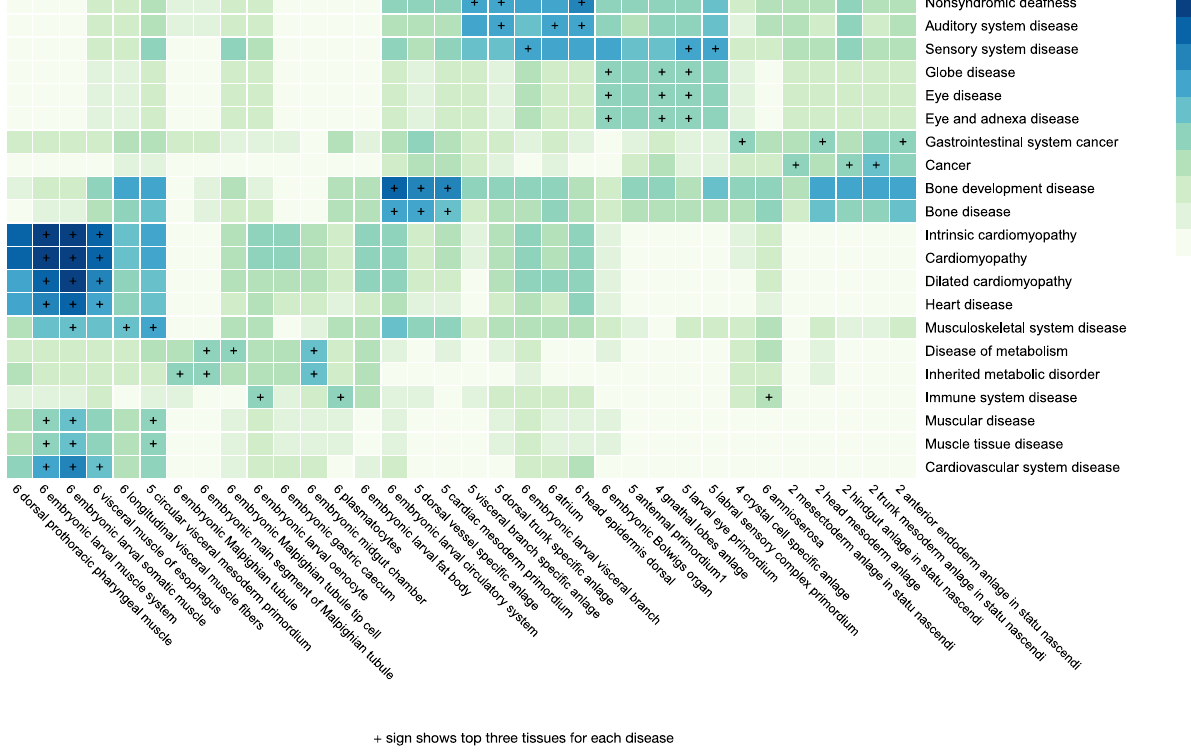
Fig 5. Prioritization of fly developmental tissues and stages for modeling human disease. Heatmap showing false discovery rate (-log10 FDR) for enrichment of human OMIM disease gene functional orthologs in each tissue-stage combination, based on FIND predictions (p-value is computed based on PAGE). The number before tissue names indicate stages (1: stage 1–3, 2: stage 4–5, 3: stage 6–8, 4: stage 9–10, 5: stage 11–12, 6: stage 13–16).